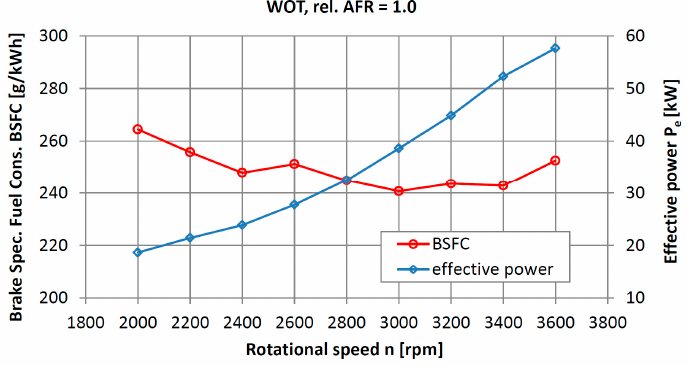
Figure 13. Effective power and BSFC as a function of engine rotational speed at WOT and with rel. AFR = 1.0; Brake Specific Fuel Consumption (BSFC); Wide Open Throttle (WOT); Relative Air-to-Fuel Ratio (rel. AFR).